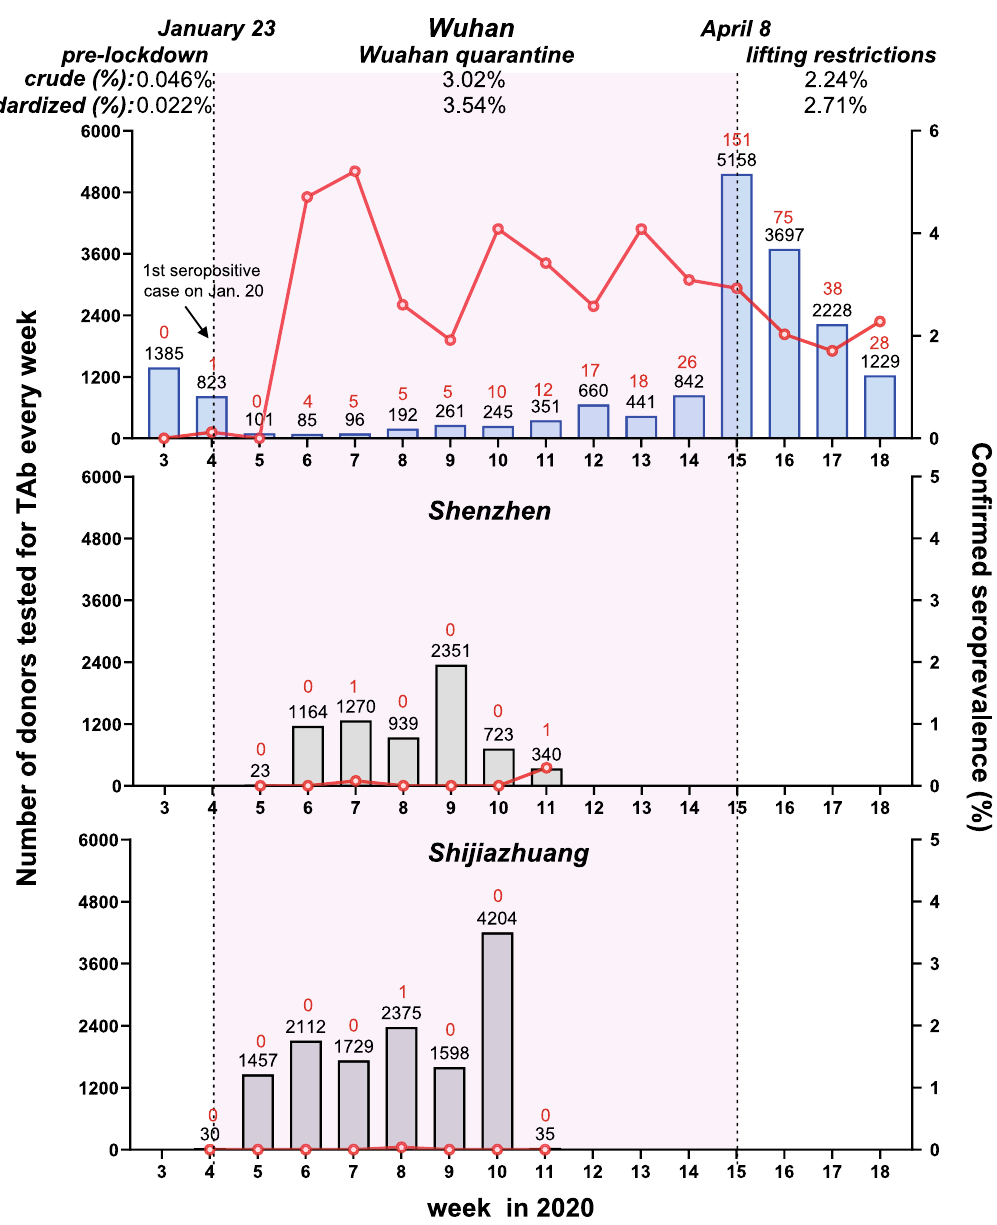
Fig. 2 Weekly seroprevalence of SARS-CoV-2 antibody during different periods from January to April 2020 in the cities of Wuhan, Shenzhen, and Shijiazhuang. The number of donors tested for total antibody (TAb) every week (the black numbers on the top of each histogram) is shown in histograms. The number of con fi rmed positive cases is shown in red numbers on the top of each histogram. The con fi rmed seropositive rate (number of con fi rmed positive donors/number of donors tested for TAb) in each week is shown in red lines. The fi rst donor con fi rmed positive by the pseudotype lentivirus- based neutralization tests in Wuhan was donated on January 20, the fourth week of 2020. Lockdown of Wuhan City started on January 23 and on April 8, all the travel restrictions in Wuhan were lifted. The period of study in Wuhan is divided into three stages: prelockdown (Jan 15 – Jan 22), lockdown (Jan 23 – Apr 7), and lifting restrictions (Apr 8 – Apr 30). The con fi rmed seroprevalences of the three stages varied: only one from 2164 donors was con fi rmed in the fi rst stage (0.046%, 95% CI: 0.082 – 0.26%); 169 donors with con fi rmed serological evidence were identi fi ed from 5587 donors, suggesting a seroprevalence of 3.02% (95% CI: 2.60 – 3.51%) in the lockdown stage. After April 8, we further tested a total of 10,043 donors, and found out that 225 were con fi rmed SARS-CoV-2 seropositive (2.24%, 95% CI: 1.97 – 2.55%). The peak of seroprevalence (5.21%, 5/96) occurred in the stage of lockdown. The seroprevalence of the three stages, after age – sex standardization with the population distribution in the city of Wuhan of 18 – 60-year-old adults,